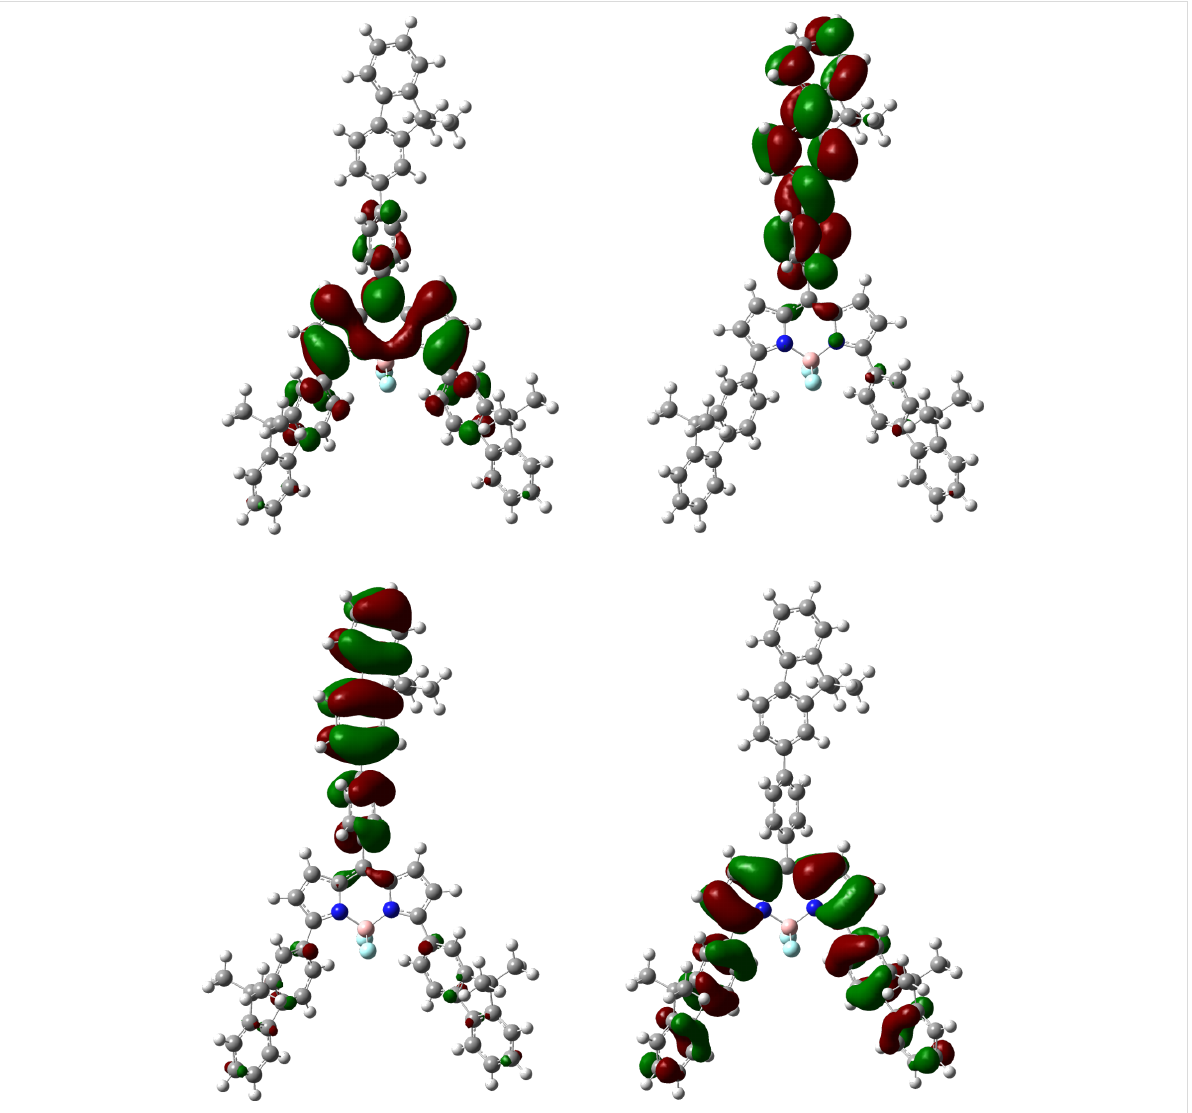
Figure 5: HOMO − 1 (bottom, left), HOMO (bottom, right), LUMO (top, left) and LUMO+1 (top, right) of Y-B1 .